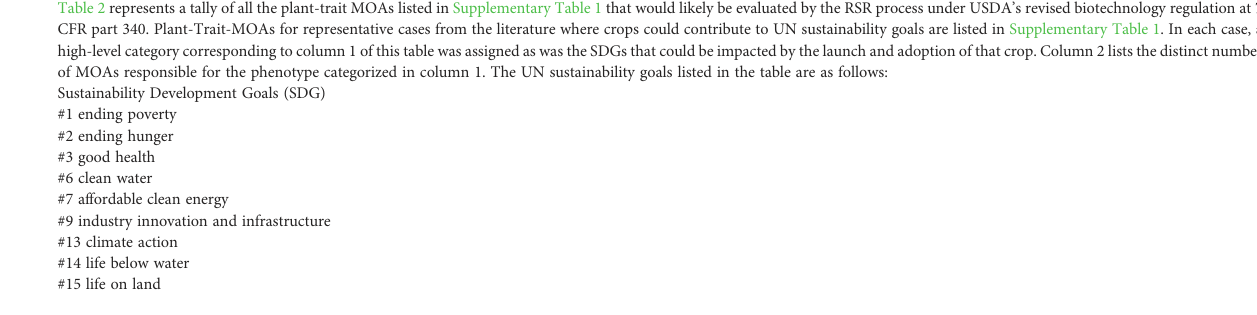
Table 2represents atallyofall the plant-trait MOAs listed inSupplementary Table 1that wouldlikely be evaluated bythe RSR processunder USDA ’ s revisedbiotechnology regulation at7 CFR part 340. Plant-Trait-MOAs for representative cases from the literature where crops could contribute to UN sustainability goals are listed in Supplementary Table 1. In each case, a high-levelcategorycorrespondingtocolumn1ofthistablewasassignedaswastheSDGsthatcouldbeimpactedbythelaunchandadoptionofthatcrop.Column2liststhedistinctnumber of MOAs responsible for the phenotype categorized in column 1. The UN sustainability goals listed in the table are as follows: Sustainability Development Goals